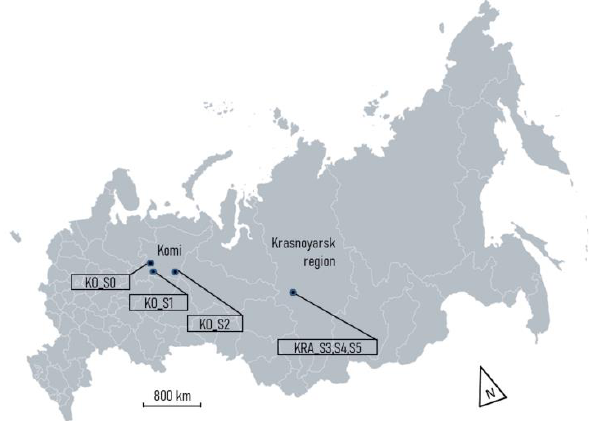
Figure 1. Location of the study sites. KO_S0—Site 0 (Maksimovsky monitoring site, Komi Republic), KO_S1—Site I (Koygorodsky National Park, Komi Republic), KO_S2—Site II (Pechoro-Ilychsky Reserve, Komi Republic), KRA_S3–Site III (Zotino, Krasnoyarsk Region), KRA_S4—Site IV (Zotino, Krasnoyarsk Region), KRA_S5—Site V (Zotino, Krasnoyarsk Region).